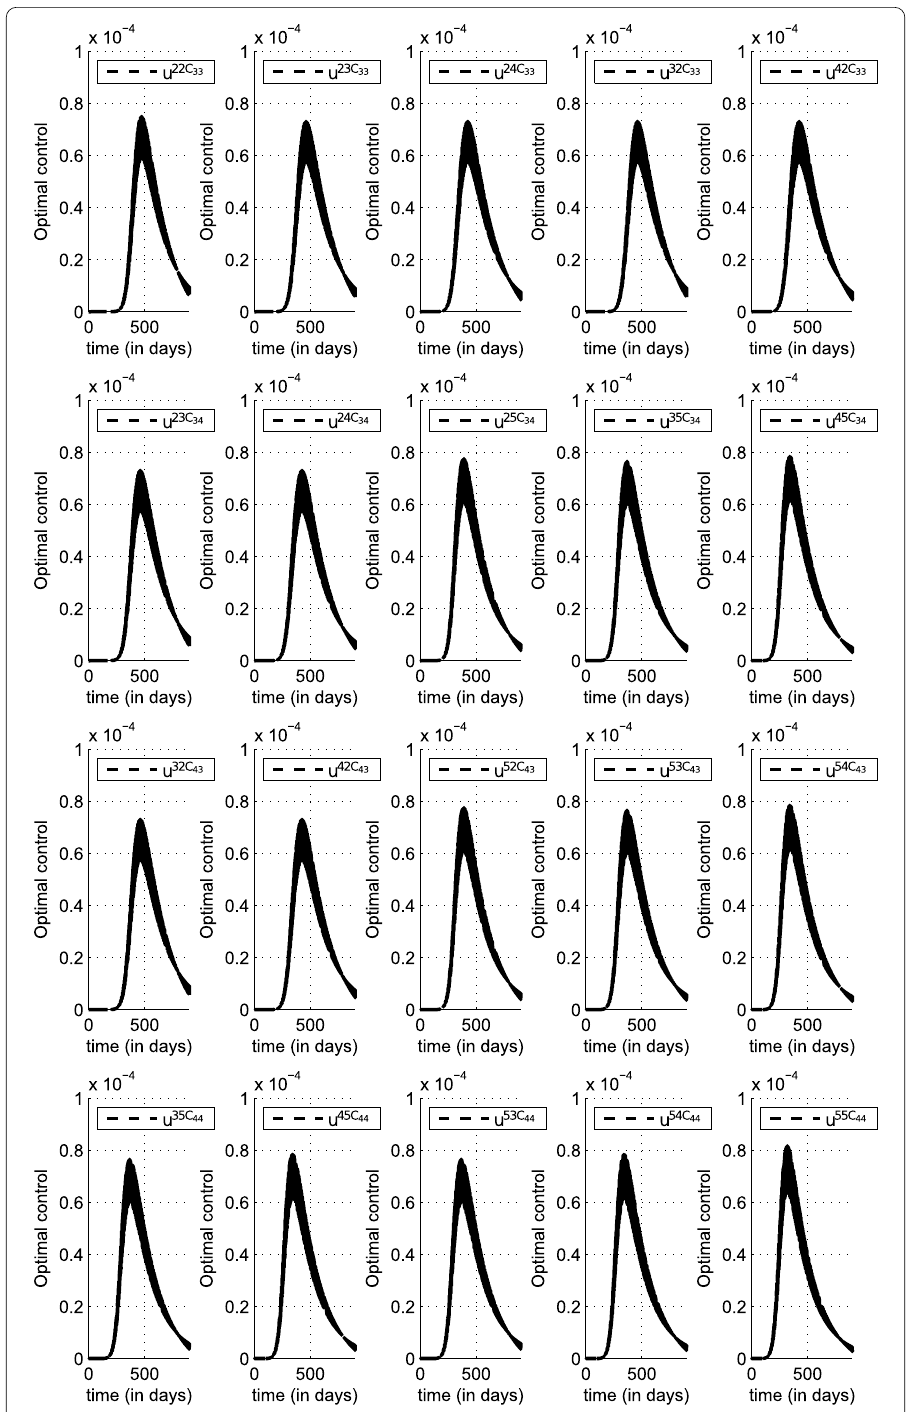
Figure 20 The optimal controls (11) associated with each cell in P (i.e., C 33 , C 34 , C 43 and C 44 ).